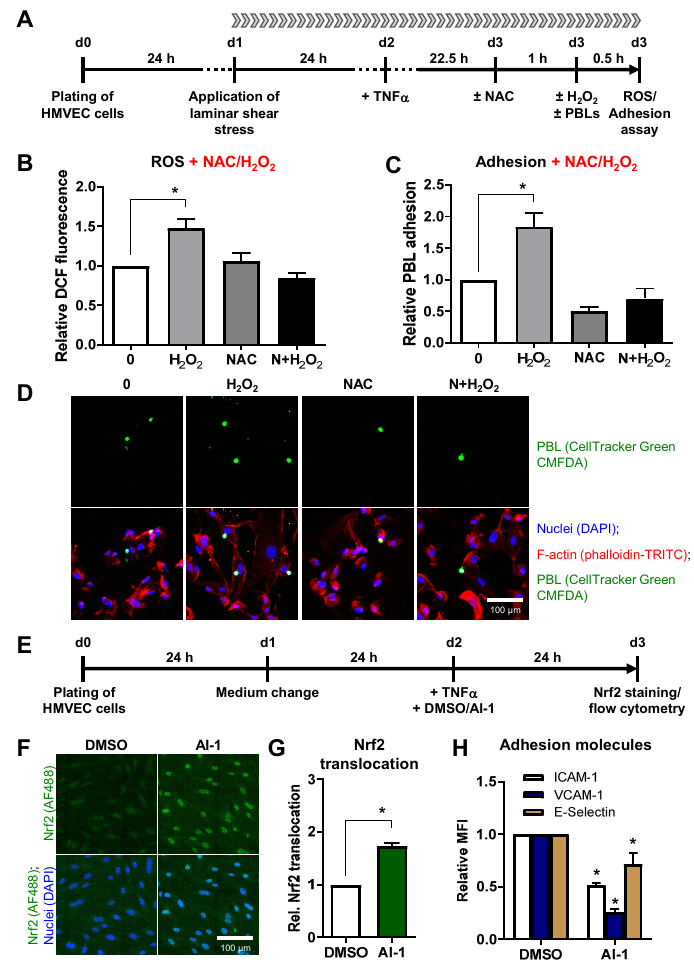
Figure 6. Oxidative stress induces leukocyte adhesion to HMVEC under shear stress and Nrf2 activation decreases adhesion molecule surface expression. ( A ) Experimental scheme: HMVEC were plated and laminar shear stress was applied 24 h before TNF- α stimulation. After 22.5 h, cells were either treated with the ROS scavenger N-acetyl-L-cysteine (NAC) or left untreated. Oxidative stress was induced 1 h later by addition of hydrogen peroxide either without (H 2 O 2 ) or with pretreatment with NAC (N+H 2 O 2 ). ( B ) ROS measurement was subsequently acquired by flow cytometry (Mean + SEM; n = 6; * p < 0.05, one-way ANOVA vs. 0 Gy). ( C ) For adhesion experiments, Cell Tracker Green-stained PBL were added to the medium reservoir of the flow chamber and adhesion to HMVEC was allowed for 30 min under laminar flow (Mean + SEM; n = 6; * p < 0.05, one-way ANOVA vs. 0 Gy). ( D ) Exemplary pictures, depicting adhered PBL (CellTracker Green CMFDA (5-chloromethylfluorescein diacetate)), either alone or merged with nuclei (DAPI, blue) and F-actin staining of HMVEC cells (phalloidin-TRITC, red). Bar, 100 µ m. ( E ) To analyze the impact of Nrf2 activation on adhesion molecule expression, HMVEC were plated, medium was changed after 24 h and cells were treated with TNF- α and DMSO or the Nrf2 activator AI-1. After 24 h, cells were fixed, stained for Nrf2 (AF488, green) and DAPI (blue). ( F ) Depicted are exemplary pictures, showing Nrf2 staining alone (green channel) or merged with nuclei (DAPI, blue). ( G ) Samples were evaluated microscopically for Nrf2 translocation, or ( H ) adhesion molecules ICAM-1, VCAM-1 and E-Selectin were measured by flow cytometry and values calculated as MFI + SEM relative to DMSO-treated cells. n = 4; * p < 0.05 (Mann-Whitney U test vs.